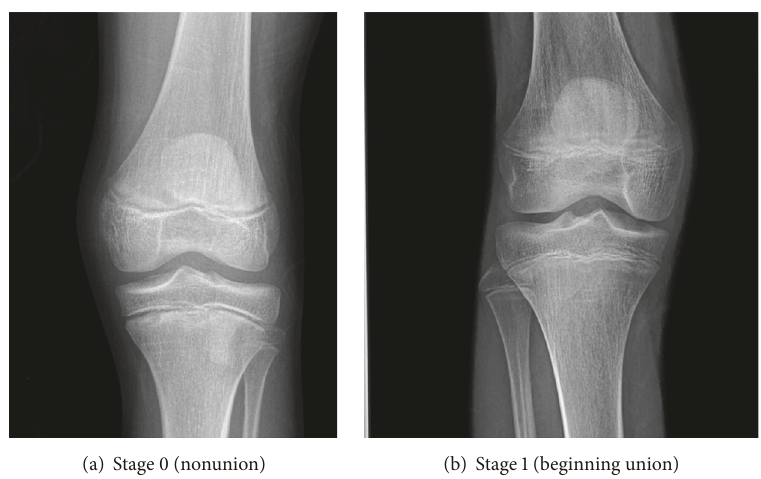
Figure 1: Radiographic images of knee joint showing stage 0 labeled as (a) and stage 1 labeled as (b).